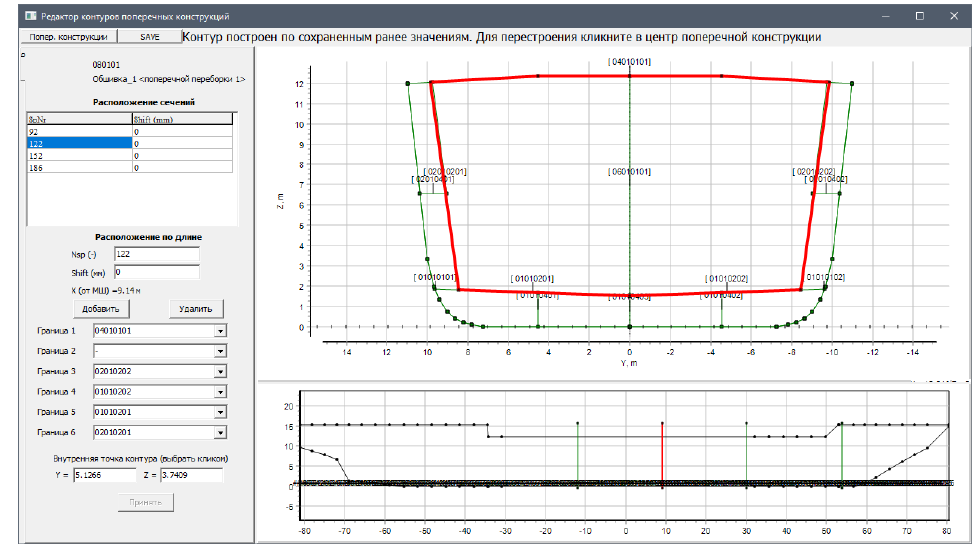
Figure 16. The results of geometric modeling of the tanker transverse bulkhead.